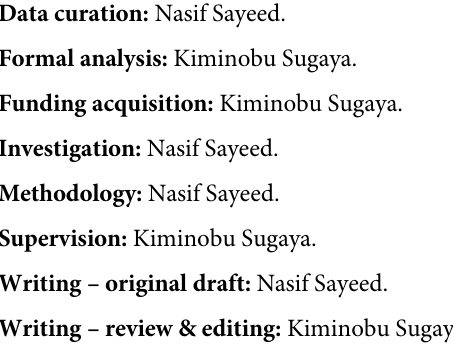
S1 Table. List of primers. These primer sets were used for quantitative real-time PCR to check gene expression used in Fig